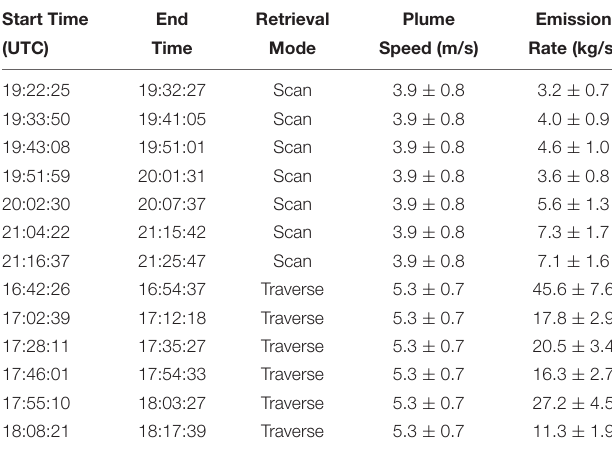
TABLE 2 | A summary of scan and traverse emission rates measured with the PiSpec. Start Time End Retrieval